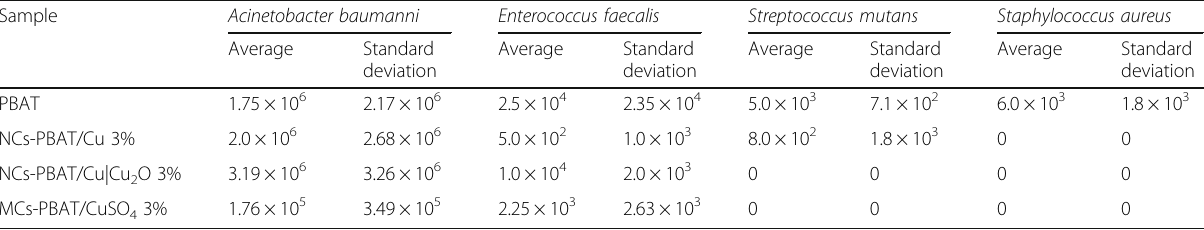
Table 5 Statistical analysis for each bacterial strain